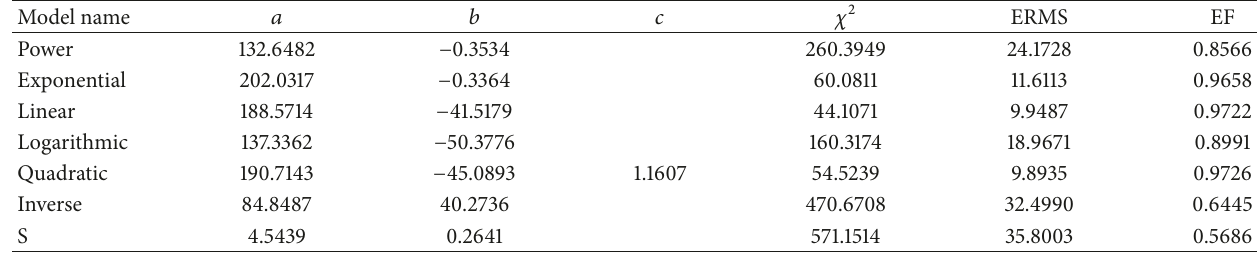
Table 3: Statistical results, constants, and coefficients of mathematical models.